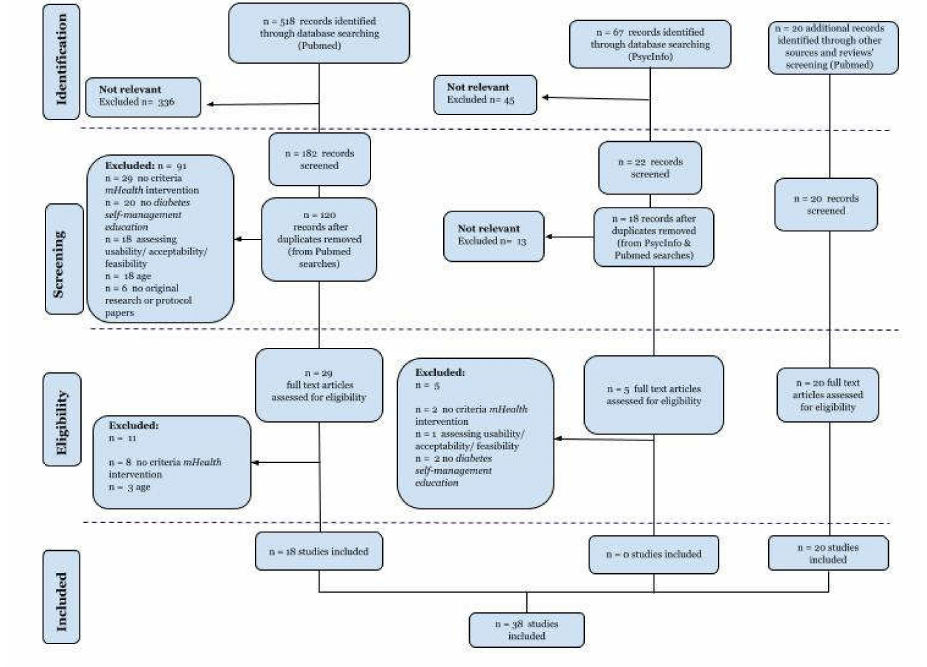
Figure 1. Flow diagram of study